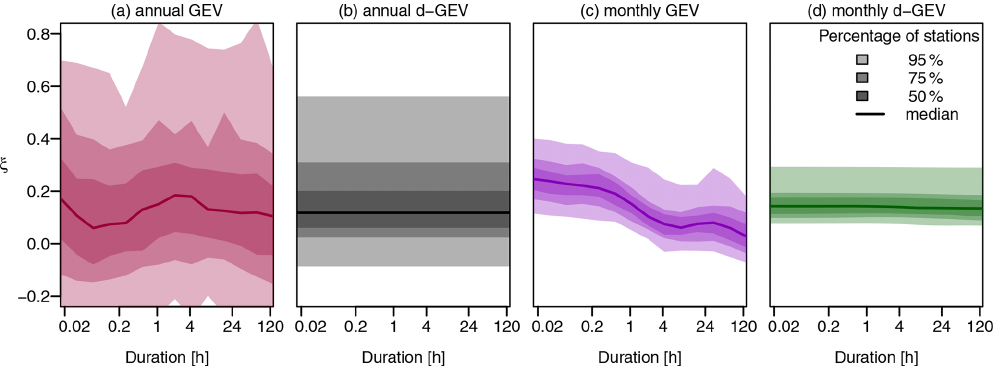
Figure 8. Distribution of shape parameter ξ estimated using four different models (columns) at all 132 stations. The shaded areas present the percentage of stations for which the estimated value lies within the respective range, while the line depicts the median